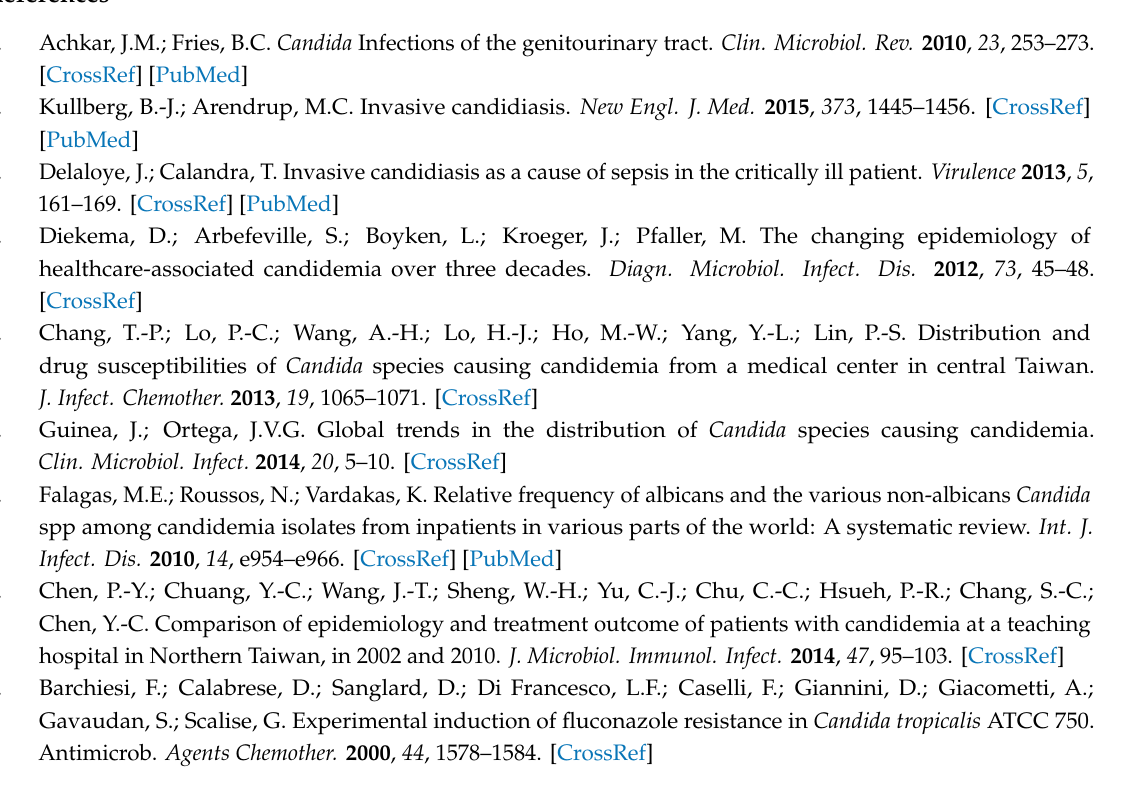
Table S1: Oligonucleotides used in this